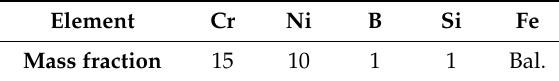
Table 3. Components of Fe–Cr–Ni–B–Si alloy powder. Element Cr Ni B Si Fe Mass fraction